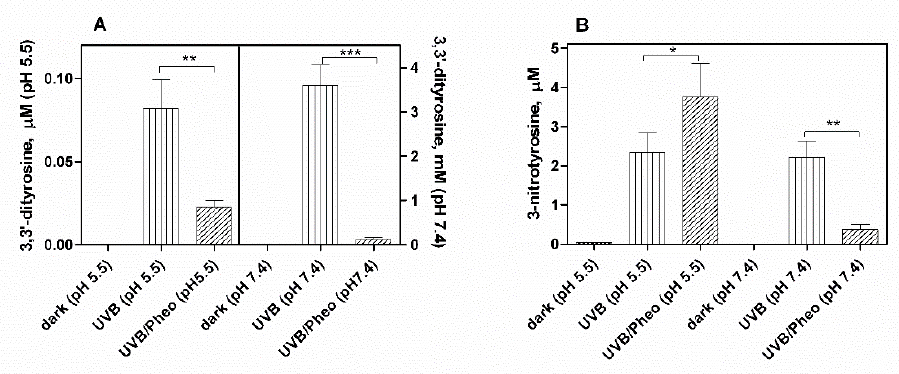
Figure 4. Photooxidation/photonitration of tyrosine by the nitrite/pheomelanin/UVB system. Pheomelanin 4.2 μ g/mL is added to reaction mixture containing 1 mM tyrosine, 10 mM K-nitrite, 0.1 mM DTPA in 0.2 M K-phosphate buffer at pH 5.5 or pH 7.4. The solution is exposed to UVB rays for 30 min. The reaction is stopped by placing the mixture in the dark and the supernatant, obtained after centrifugation, is analyzed by HPLC to measure 3,3’-dityrosine ( A ) and 3- nitrotyrosine ( B ), as reported in Materials and Methods. Controls in the dark correspond to unex- posed reaction mixtures (pheomelanin/nitrite/tyrosine system).*** p < 0.001, ** p < 0.01, * p < 0.05 .